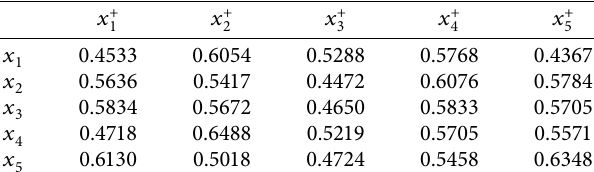
Table 4: Distance set between attribute values of each scheme and corresponding values of NIS.